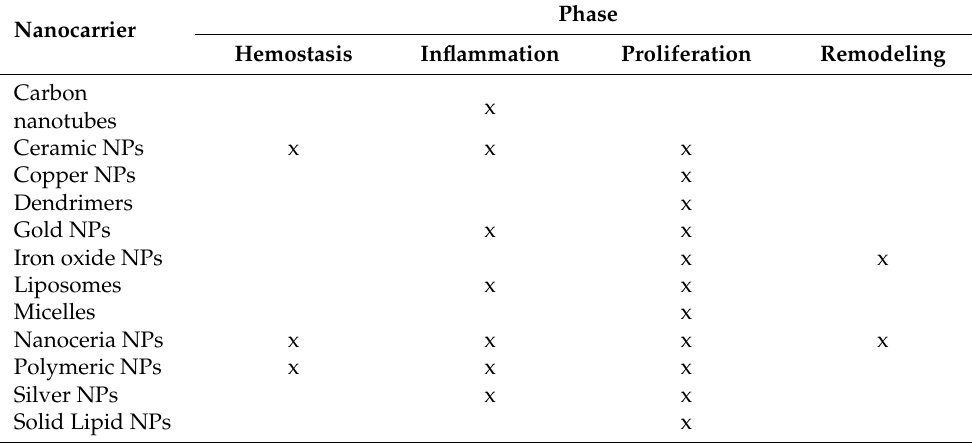
Table 3. Various therapeutics delivered by nanocarriers in wound healing therapies, according to Barroso et al. [181]. Key to symbols: